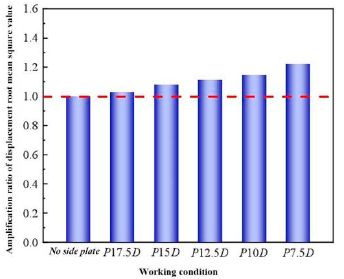
Figure 21. Along-wind displacement response at monitoring point 1 under a windspeed of 12 m/s and different pitch conditions.